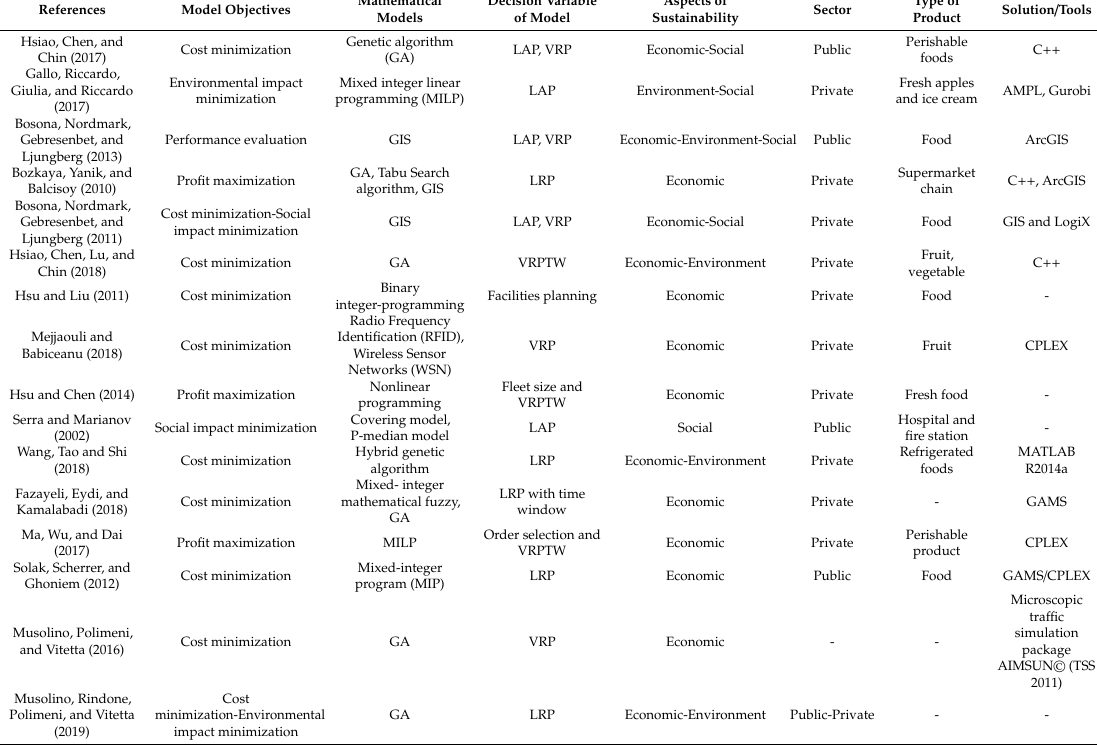
Table 1. Summary of literature review: location–allocation problem(LAP); vehicle routing problem (VRP); location-routing problem (LRP); vehicle routing problems with time window